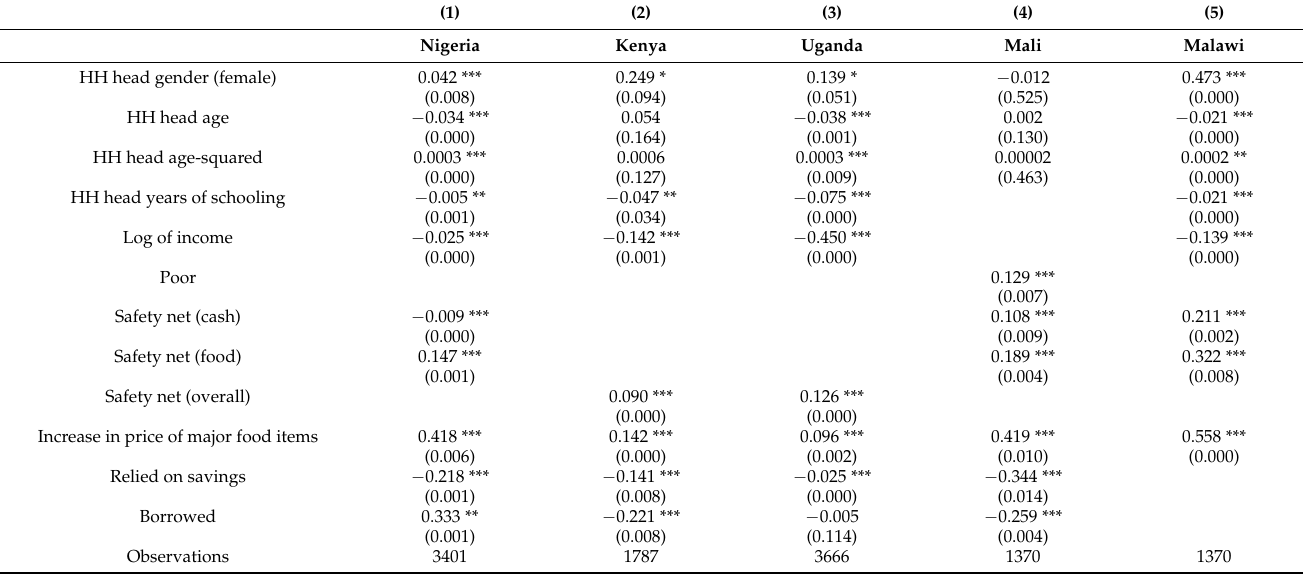
Table A1. Determinants of food insecurity—skipped a meal.